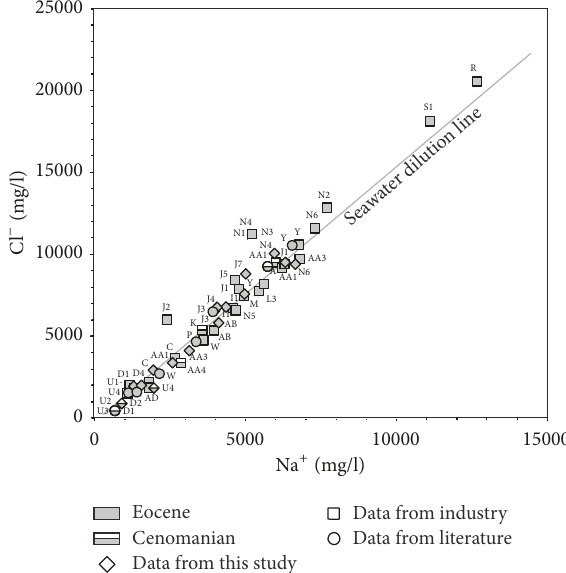
Figure 5: Cross-plot of Na + against Cl − dissolved in the water coproduced with oil. For comparison, data from this study are plotted together with industry and literature data. Deviation of the water from the seawater dilution line is probably caused by reservoir